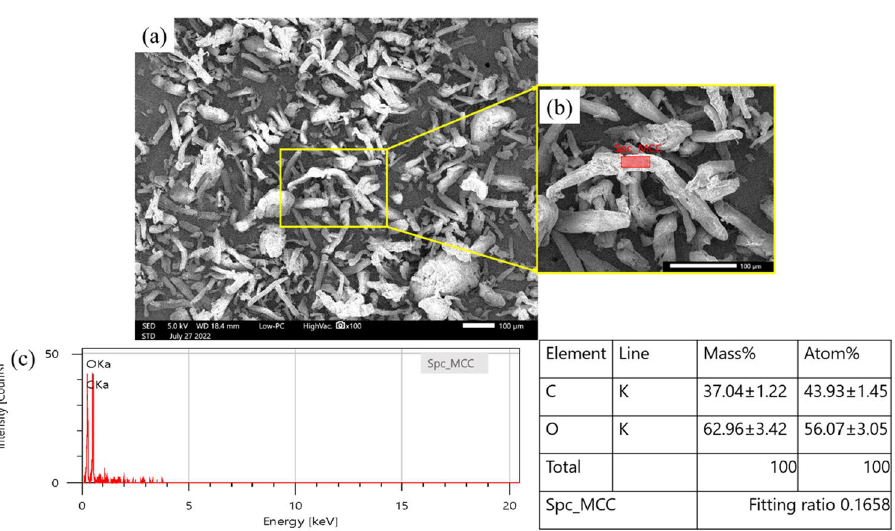
Figure 5. SEM–EDX analysis of the MCC elements: ( a ) the SEM micrograph of the shape surface morphology of the MCC powder, ( b ) the EDX point area, and ( c ) the EDX spectrum and right table for the atomic percentages and weights of the various MCC